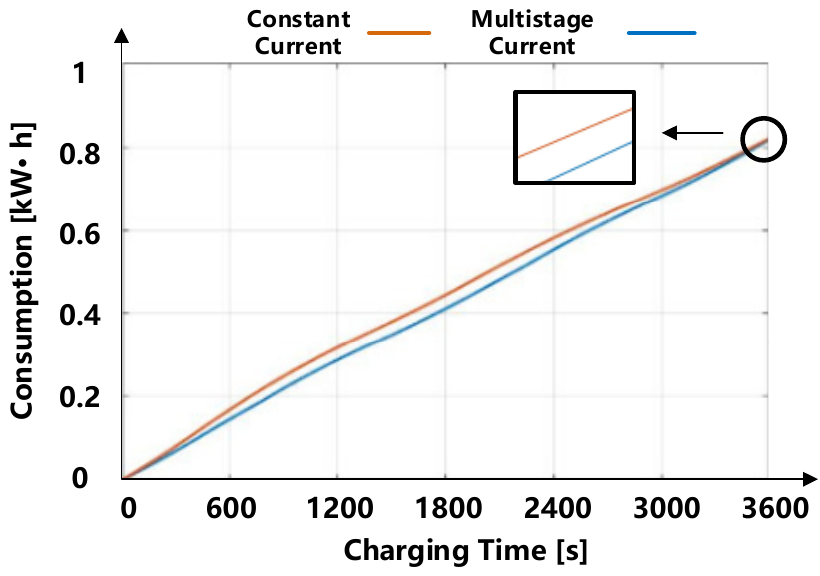
Figure 14. Energy c onsumption of multistage current and constant current charging method of one Figure 14. Energy consumption of multistage current and constant current charging method of one battery in SM of phase A. battery in SM of phase A.